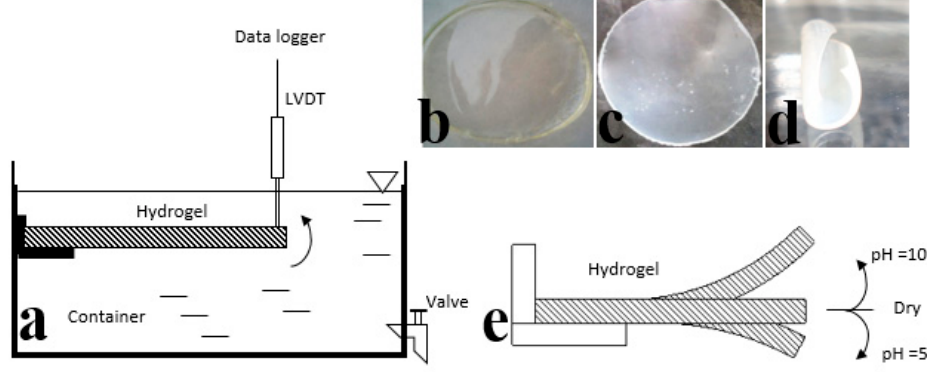
Figure 2. ( a ) Schematic drawing for assessment of pH sensitivity of PVA-PAA samples (the PVA side was upward) using a linear variable displacement transformer (LVDT) sensor. Images of PAV-PAA samples ( b ) Swollen at pH = 5; ( c ) Dry; ( d ) Swollen at pH = 10; and ( e ) Schematic drawing of PVA-PAA samples bending at different pH values.